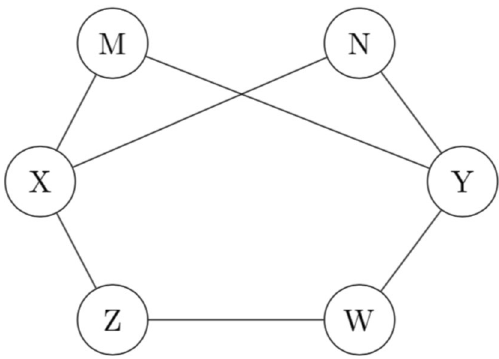
Figure 8. Example of Paths of length 2 and greater than 2 between X and Y